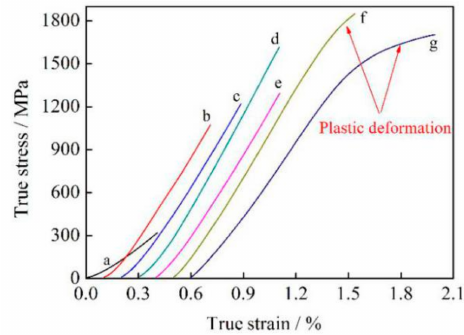
Figure 10. True stress–strain curves for flexural testing of W-6Ni-4Co alloys by the di ff erent sintering processes: ( a ) 1200 ◦ C, 30 min; ( b ) 1450 ◦ C, 5 min; ( c ) 1450 ◦ C, 20 min; ( d ) 1450 ◦ C, 60 min; ( e ) 1500 ◦ C, 5 min; ( f ) 1500 ◦ C, 20 min; ( g ) 1500 ◦ C, 60